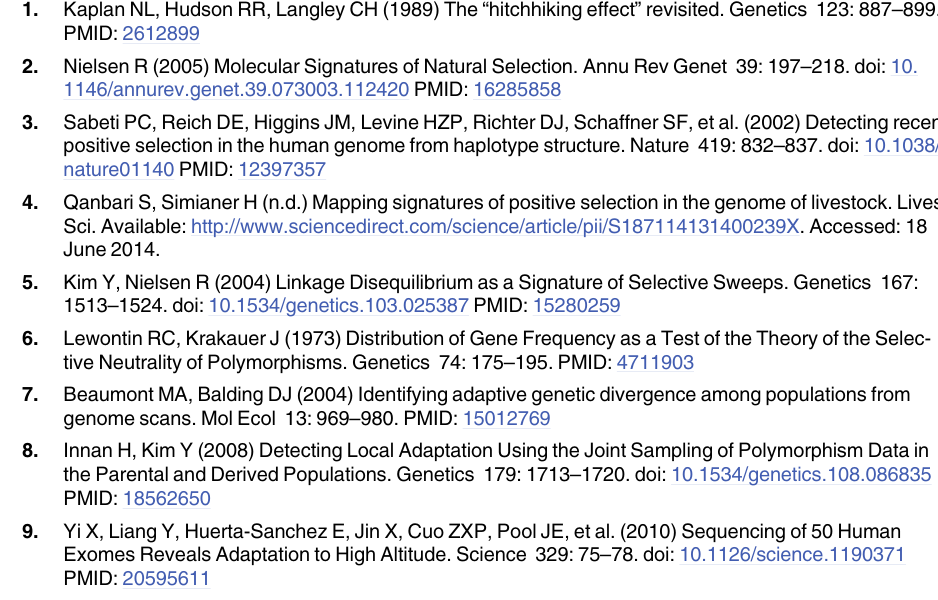
S14 Table. Lists of pathways and gene ontologies under selection with hapFLK with 0.05% threshold in brown layers. S15 Table. Regions detected as putative selective sweeps detected with F and lower (L) 1% threshold. LG stands for studies between commercial-layers and non-com- mercial chickens and BW stands for studies between brown and white layers,